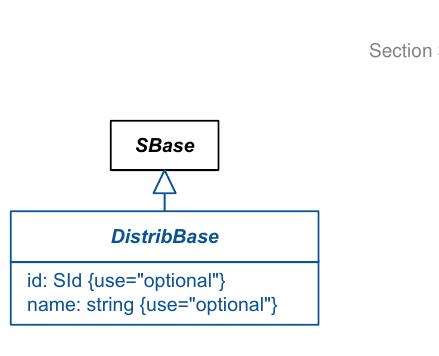
Figure 1: The definition of the DistribBase class. The id and name attributes defined are optional, and are identical to the ones they inherit in SBML Level 3 Version 2 documents from SBase .